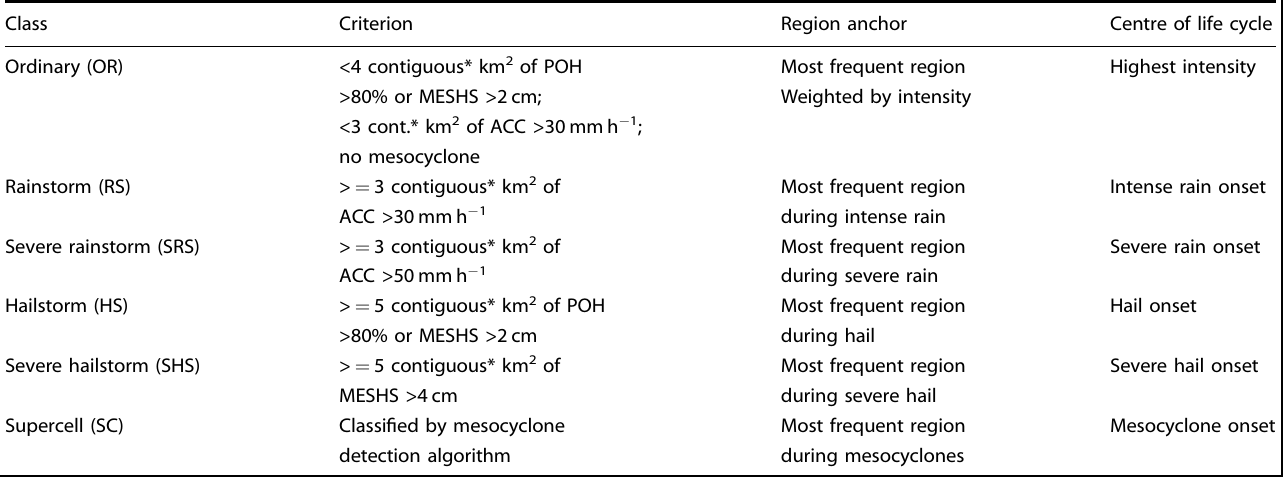
Table 3. Thunderstorm classi fi cation; *contiguous refers to corner-connectivity.